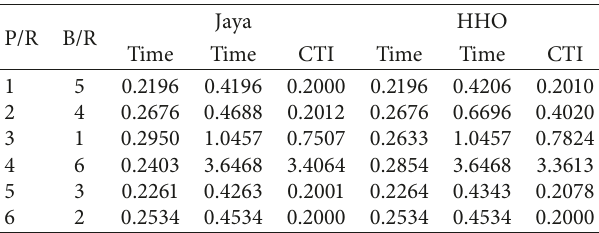
Figure 5: Independent runs for the 3-bus system by NLP formulation. Table 5: Operating time and CTI for the 3-bus system by NLP formulation.